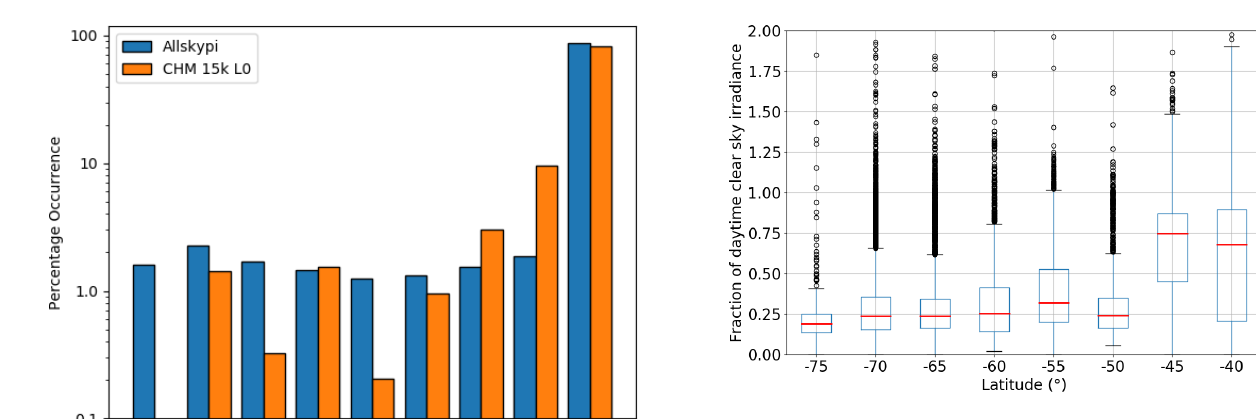
Figure 10. Box plot showing the upper to lower quartiles of the ratio of downwelling shortwave solar radiation (Sd inWm − 2 ) re- ceived by the Eppley precision spectral pyranometers to the the- oretical clear-sky value calculated for an atmospheric transmission coefficient of 0.86, on a minute-by-minute basis throughout the voy- age and categorised centred on 5 ◦ latitude bands (e.g. − 40 ◦ cate- gory ranges from − 42.5 to − 37.5 ◦ ). The number of data points in- cluded in each box plot are 1629 (lat band − 75 ◦ ), 16032 (lat band − 70 ◦ ), 7837 (lat band − 65 ◦ ), 3325 (lat band − 60 ◦ ), and about 2000 data points collected in transit latitudes to the